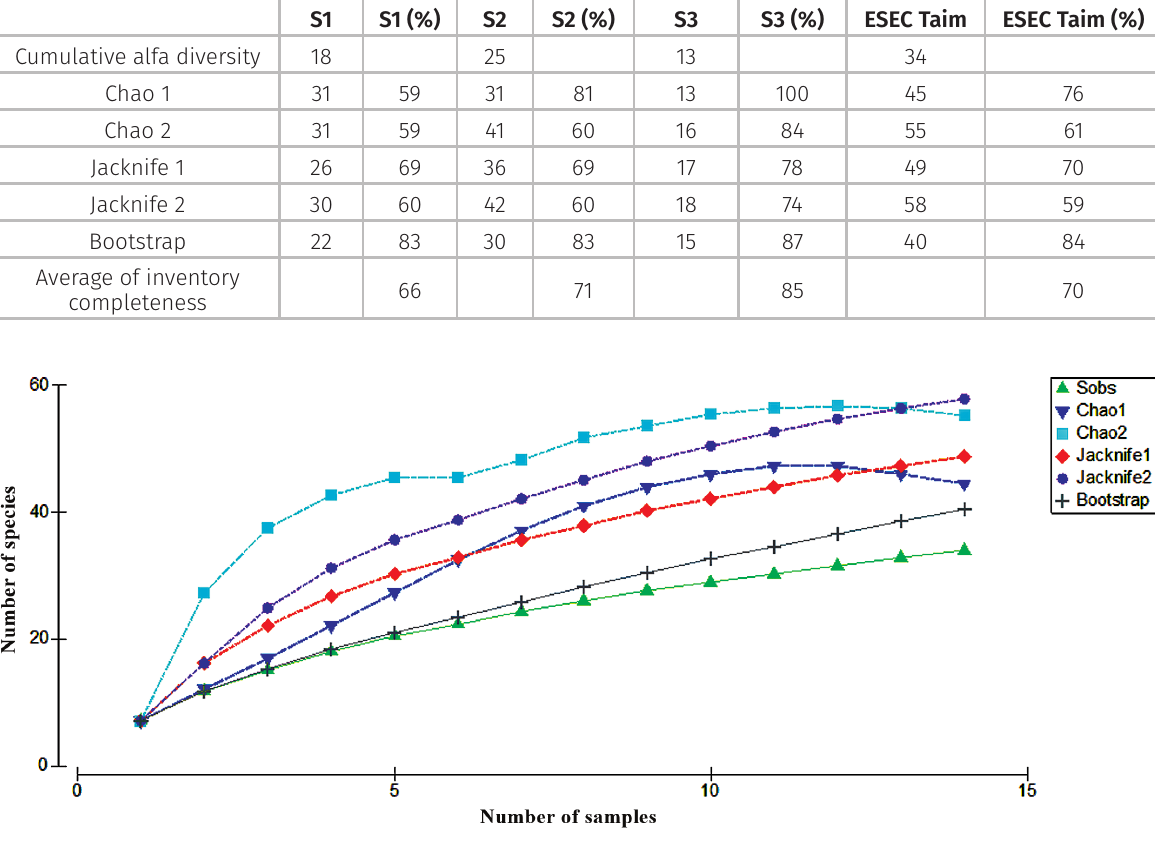
Table II. Number of species expected and percentages of inventory completeness according to different richness estimators at the three sampling sites (S1, S2 and S3) and lumped samples (ESEC Taim). S1 S1 (%)